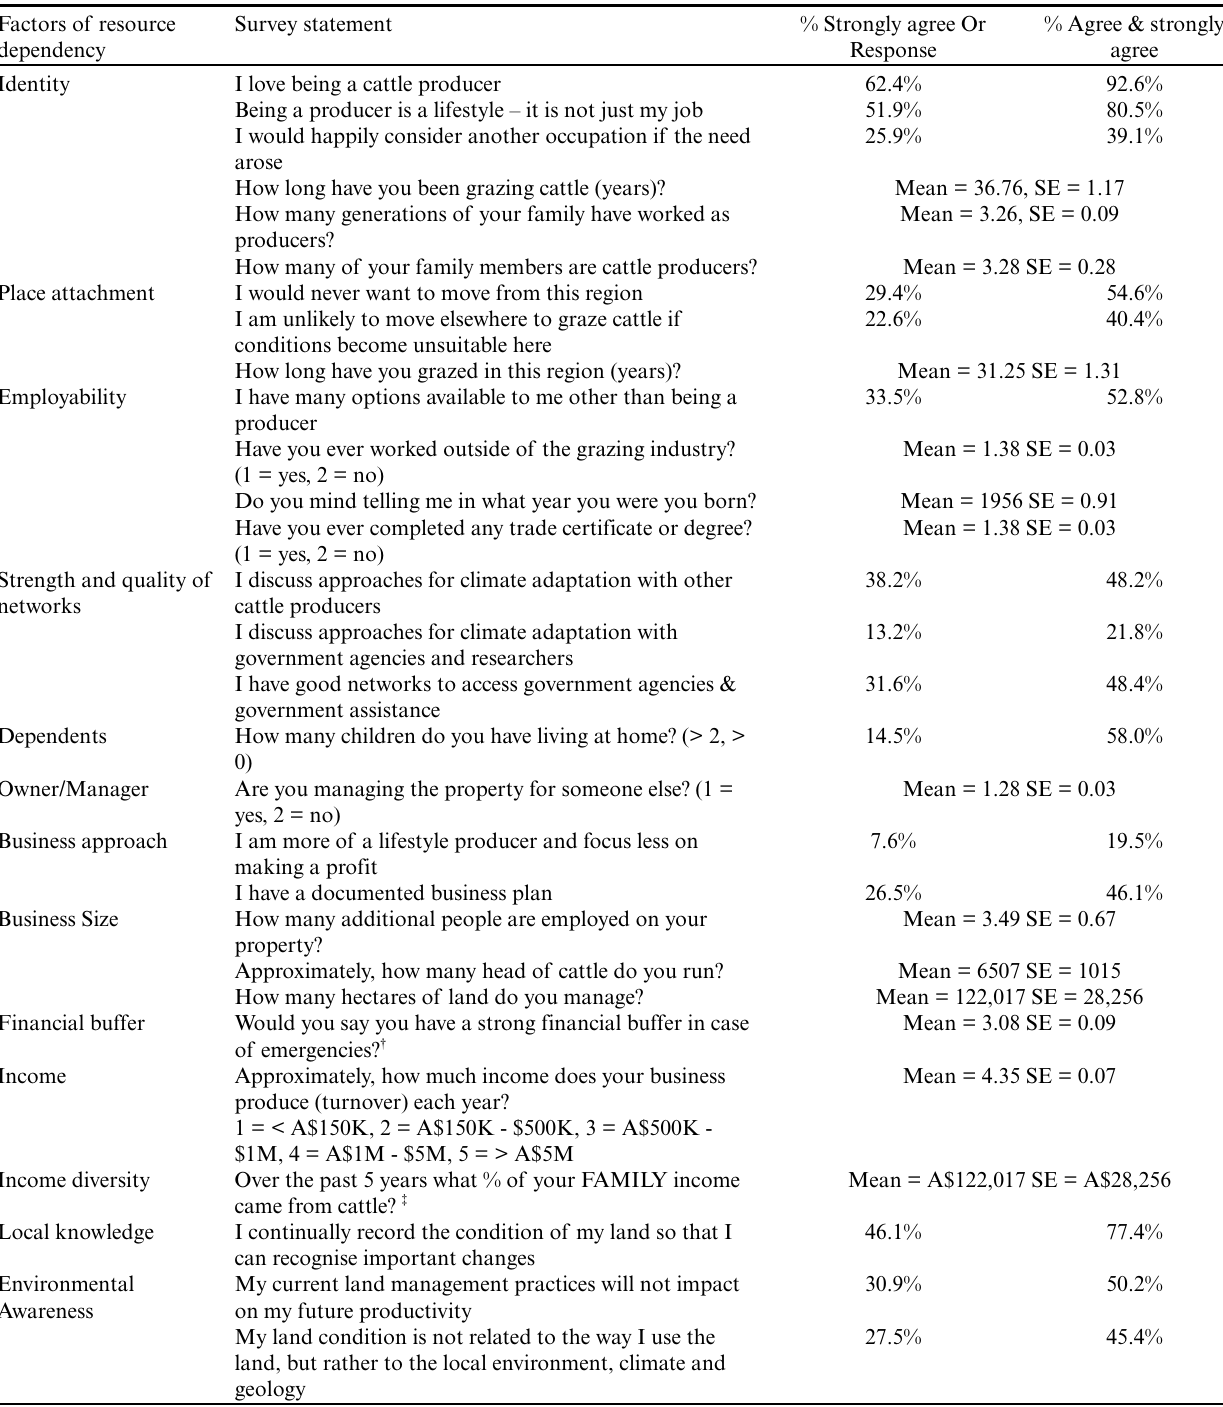
Table 2 . Level of resource dependency within the cattle industry of northern